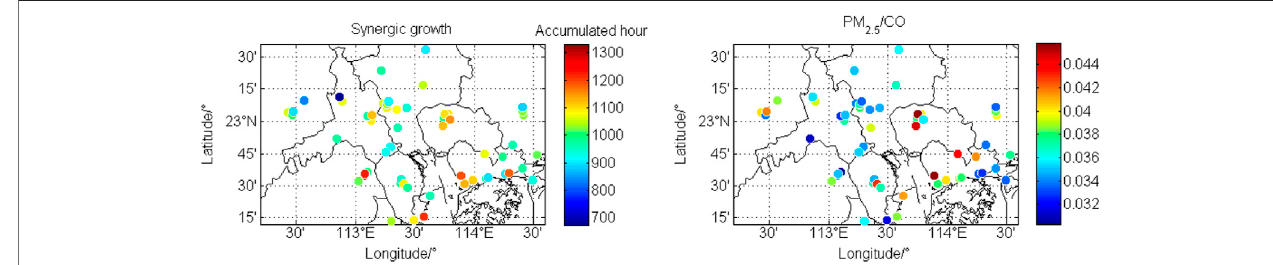
FIGURE 6 | Coordinated increase time and PM 2.5 /CO distribution in the PRD.